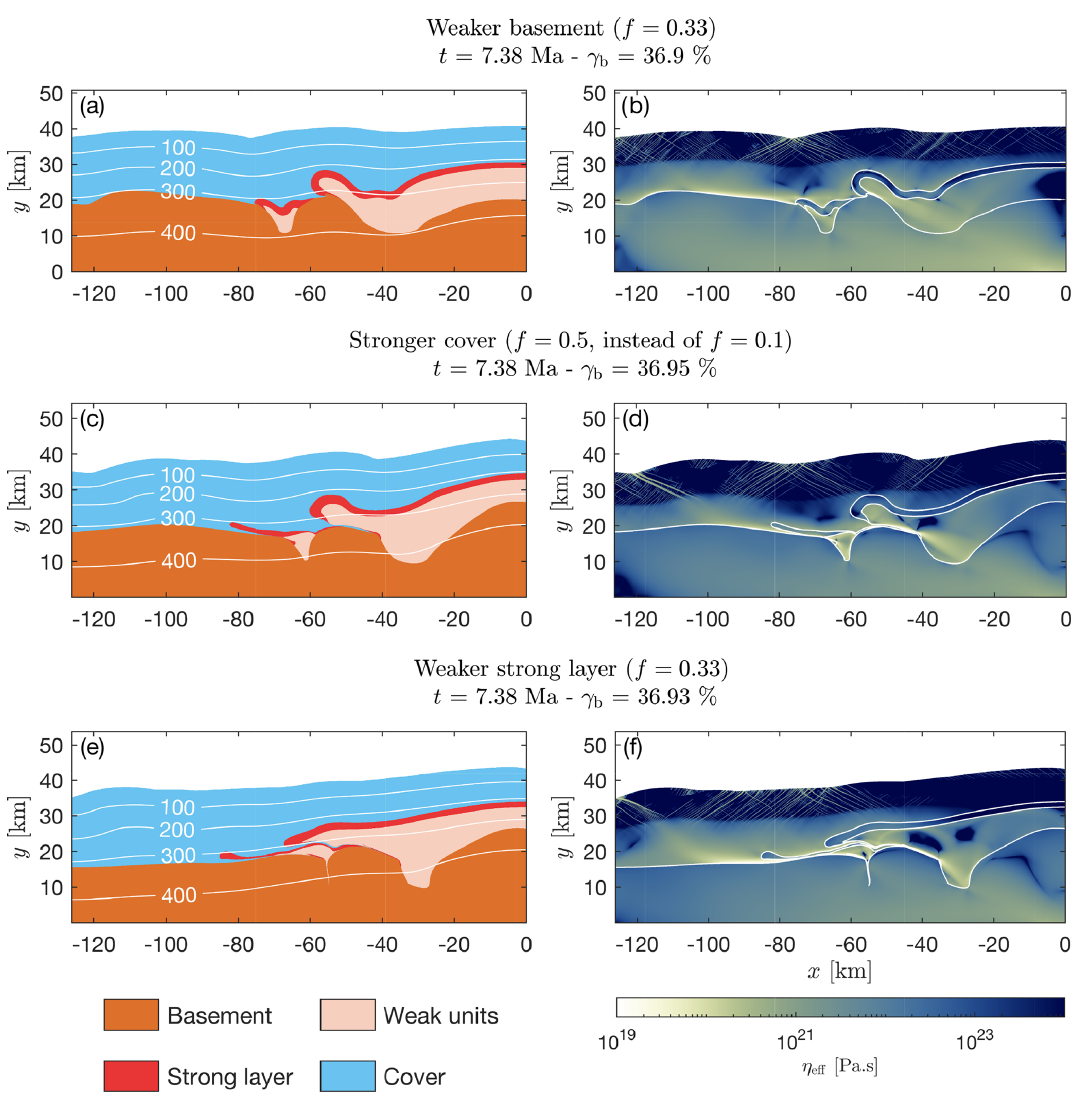
Figure 6. The final geometry, temperature and viscosity fields of three simulations with different f factor for certain model units (see figure